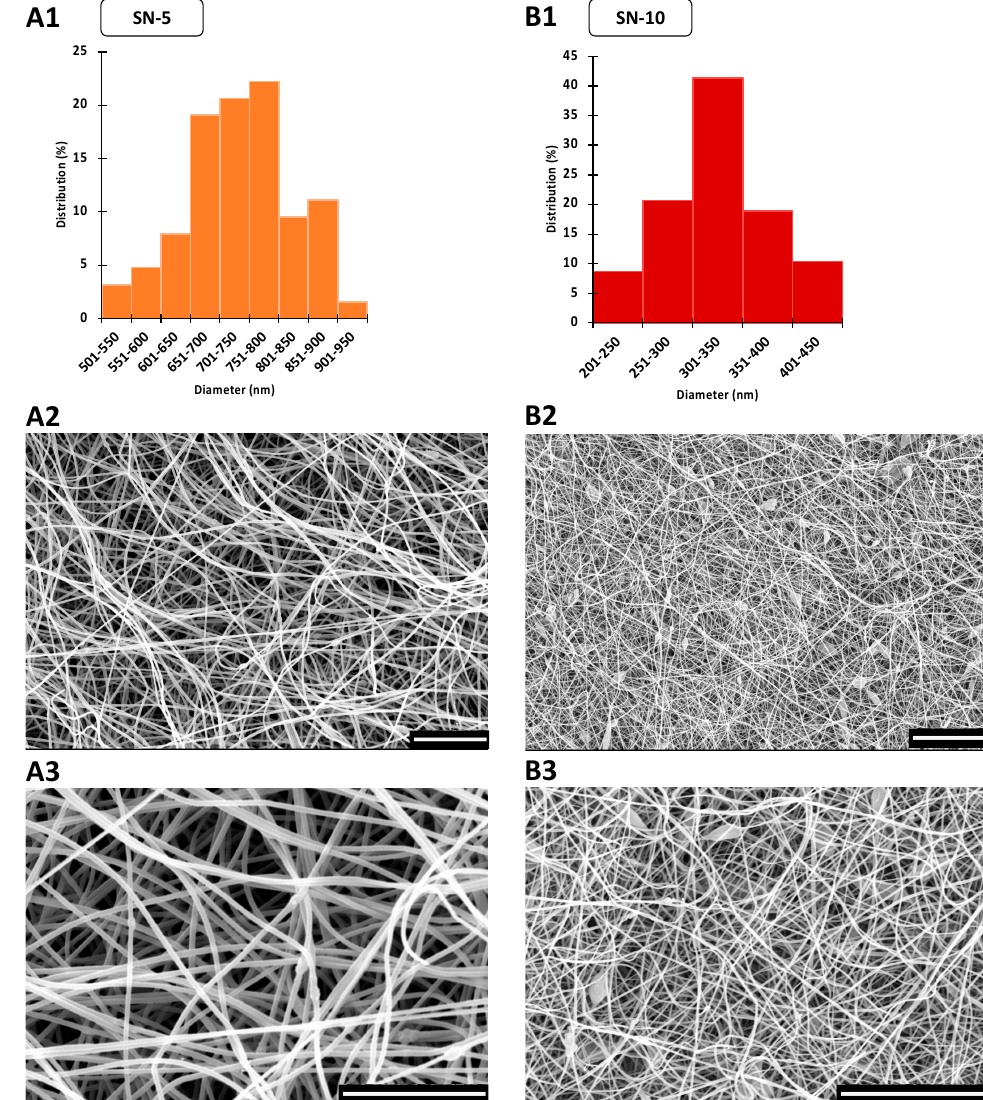
Figure 2. SEM images and diameter distributions of nanofibrous samples produced via nozzle-based electrospinning. The scale bar is 20 µ m on every microscopic image. ( A1 ) The average fiber diameter was 323 ± 51 nm in the case of nanofibers containing 5 w% ciprofloxacin (SN-5). The size distribution of nanofibers was monodisperse. ( A2 , A3 ) The morphology of the fibers was mainly uniform, but some beads formed. ( B1 ) In the case of the nanofibers containing 10 w% ciprofloxacin (SN-10), the average fiber diameter was significantly larger (735 ± 91 nm). The size distribution had a bell shape. ( B2 , B3 ) In addition to the numerous beads, large sack-shaped formations also appeared proving the imperfect electrospinning